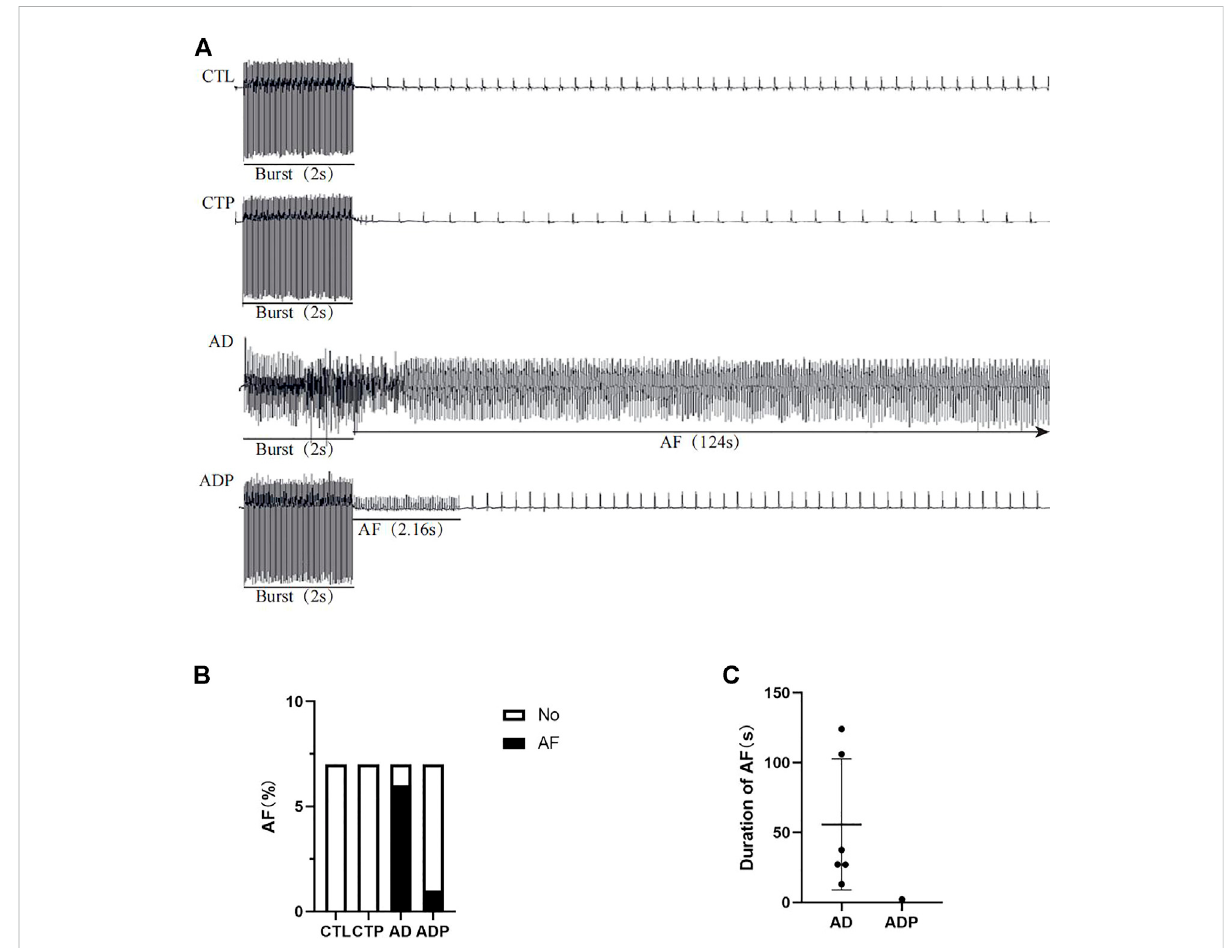
FIGURE 5 AF susceptibility. (A) Typical recordings of AF. (B,C) Inducibility and duration of AFs. n = 7 per